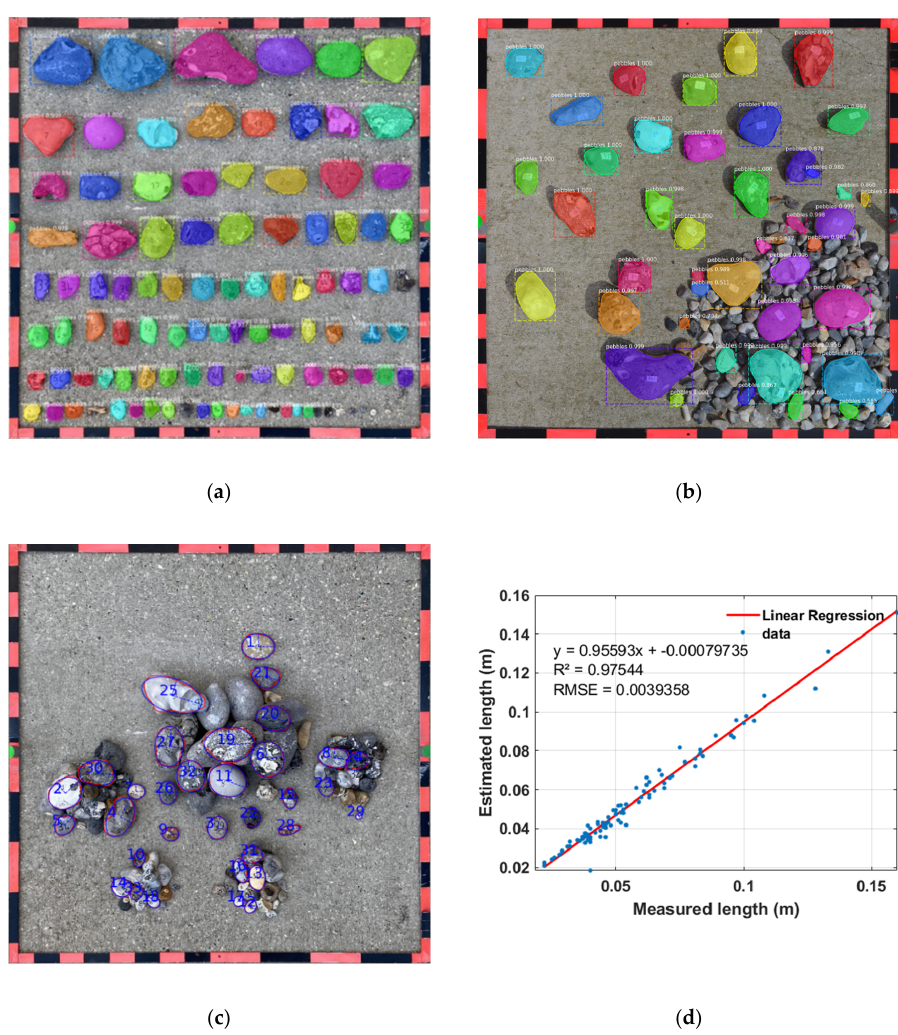
Figure 4. Application of Mask R-CNN to manually measured validation data with ( a ) a non- overlapping disposition of the clasts (colors show the detected pebble instances), ( b ) an image including overlapping objects, ( c ) the overlapping scenario tested with the highest number of misidentifications (instances n°4 and n°25) and ( d ), a comparative distribution of the pebble major axis measured after Mask R-CNN detection vs. the data measured manually using a caliper.